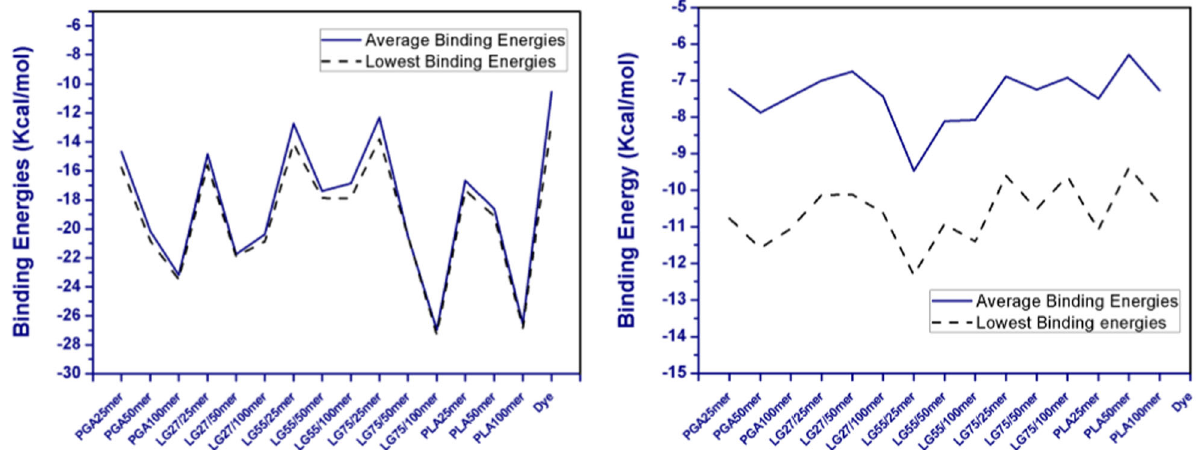
Fig. 10 The average and lowest binding energies of the A different polymer chains with self B polymer chains with coumarin-6